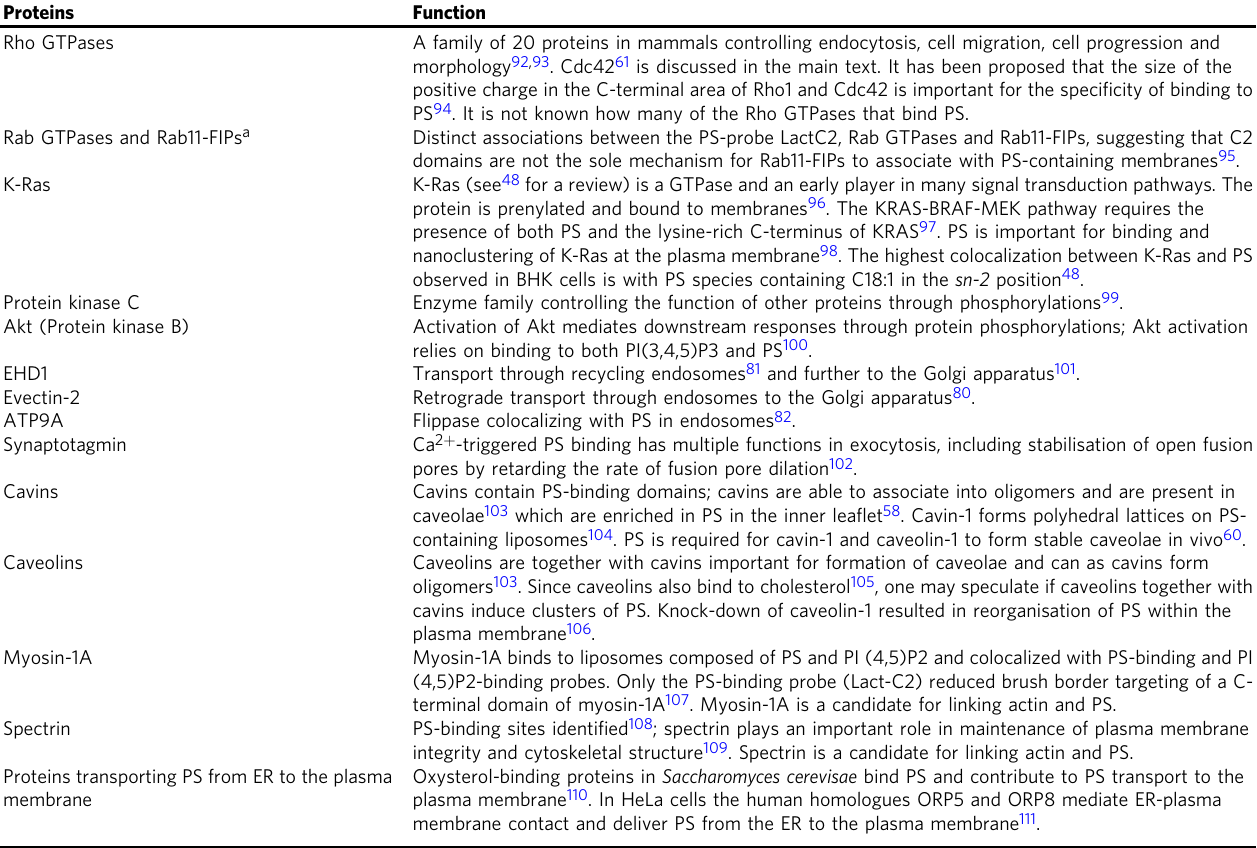
Table 4 Examples of PS-binding proteins